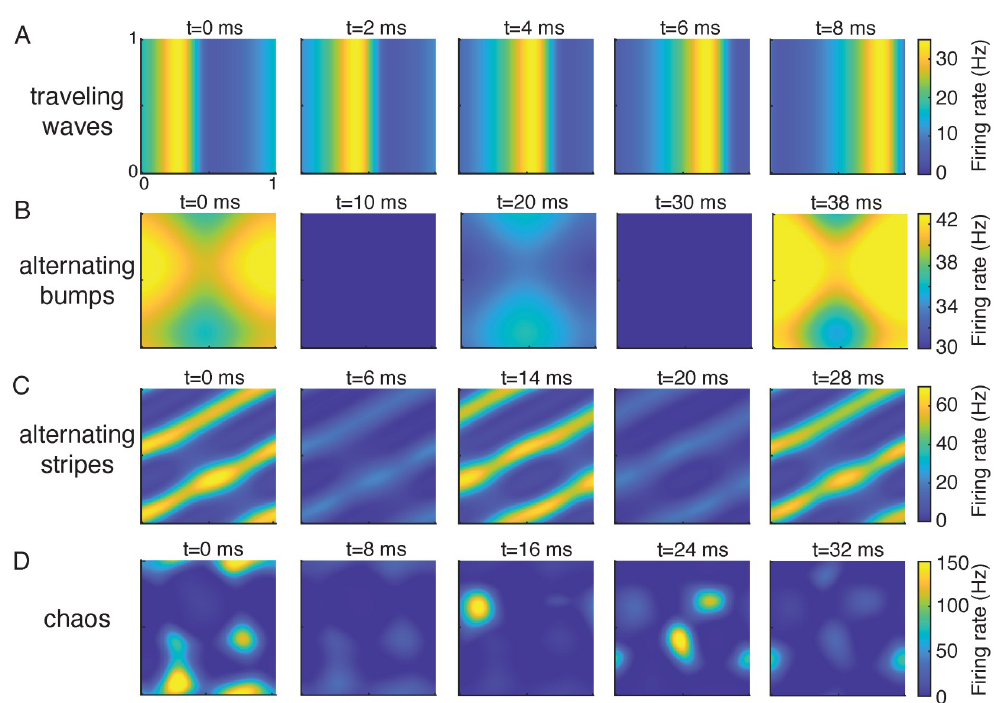
Fig 3. Examples of solutions in networks with two-dimensional spatial coupling. A-D , Snapshots of the firing rates of the excitatory population at five time frames. A , traveling waves solution ( τ i = 8, σ i = 0.1). B , alternating bumps solution ( τ i = 9, σ i = 0.06). C , alternating stripes solution ( τ i = 9, σ i = 0.1). D , chaotic solution ( τ i = 12.8, σ i = 0.096). The axes are the neuron location on the two-dimensional neuronal